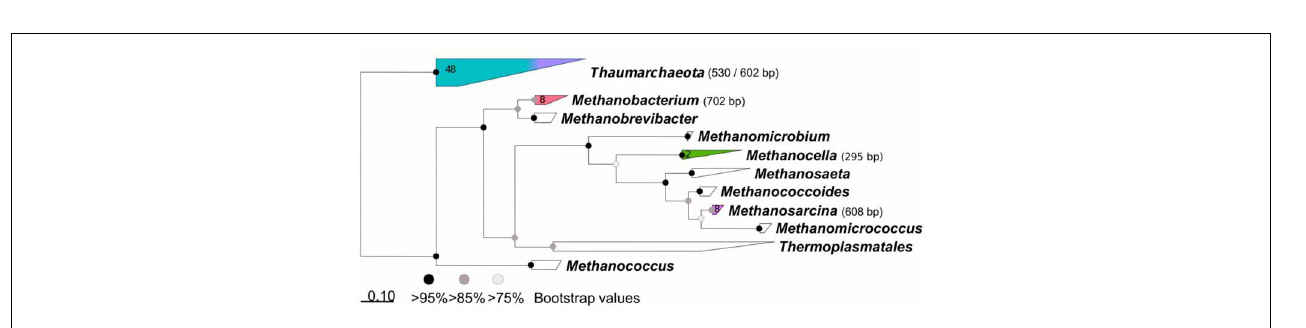
FIGURE A2 | Archaeal 16S rRNA phylogenetic tree. Maximum likelihood phylogenetic tree based on aligned partial 16S rRNA gene sequences obtained from clones from four incubated soil samples. Clusters containing sequences